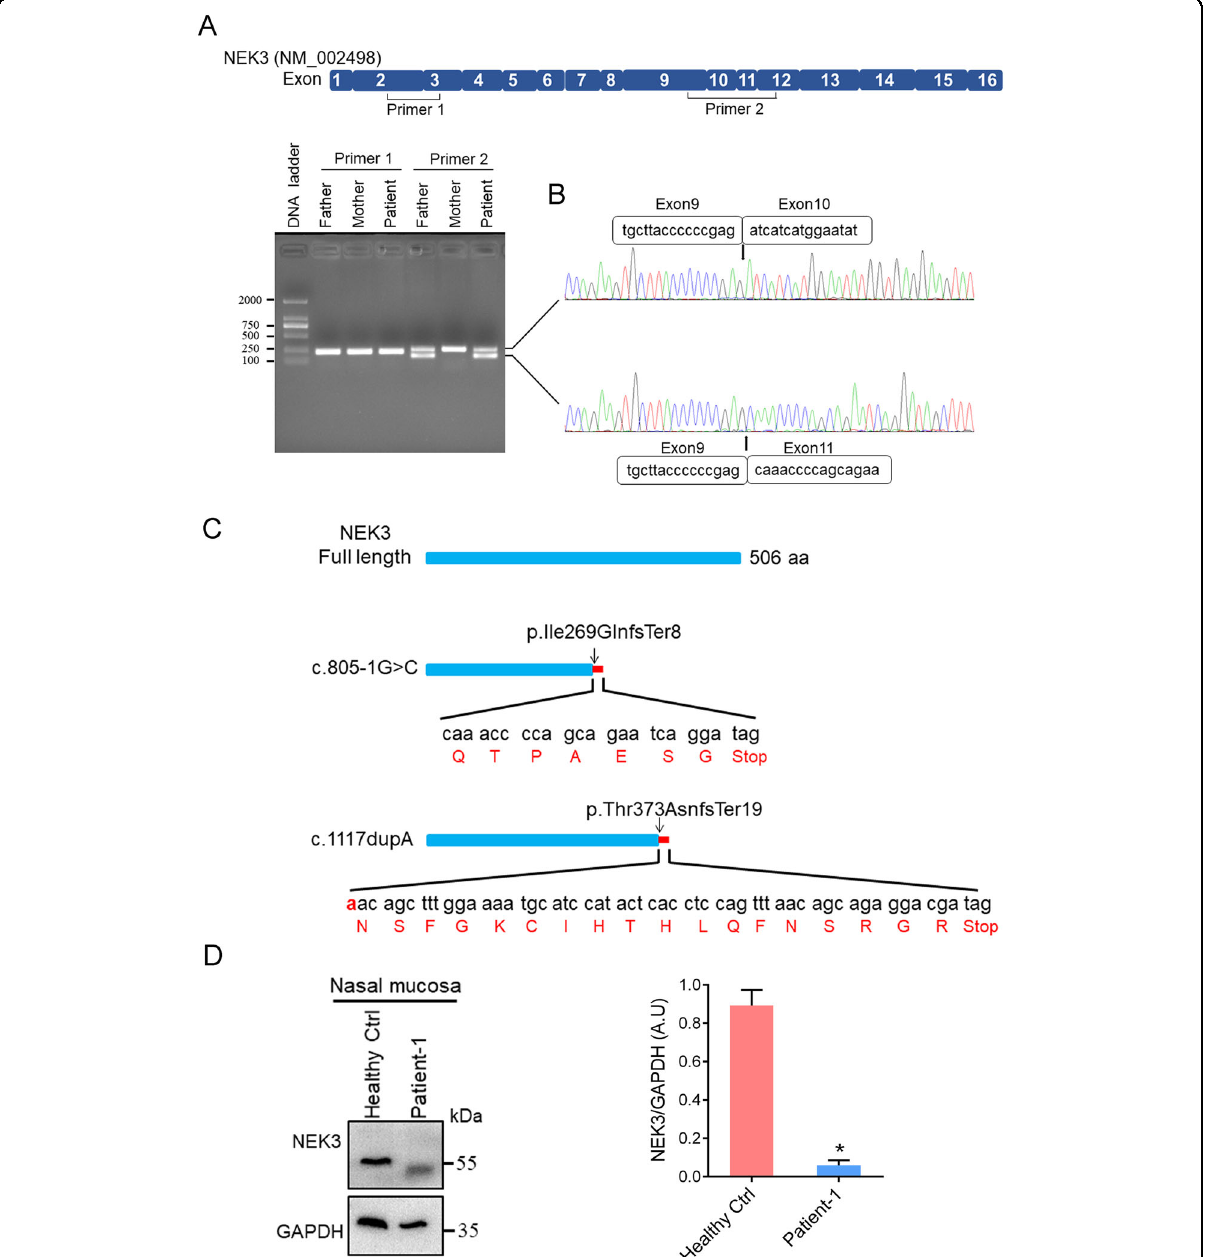
Fig. 2 NEK3 c.805-1G>C causes exon-10 skipping and premature termination of translation. a Ampli fi cation of cDNA derived from fresh blood samples of the patient and his parents by using two different pairs of primers (primer-1 and -2) as indicated. b Sanger sequencing demonstrated that exon 10 (73-bp) was skipped in the smaller band in the patient and his father carrying c.805-1G>C when using primer-2. c Compared with full-length protein (506 amino acids), both NEK3 c.805-1G>C (p. Ile269GlnfsTer8) and c.1117dupA (p. Thr373AsnfsTer19) lead to premature termination of translation. d Protein levels of NEK3 in the nasal mucosa of Patient-1 and healthy individual were evaluated by western blot. GAPDH served as a loading control. Right panel: Quanti fi cation data of NEK3 expression level when normalized against GAPDH. * p value <0.05 (Mann – Whitney U test). AU arbitrary units. Representative image from three independent experiments was